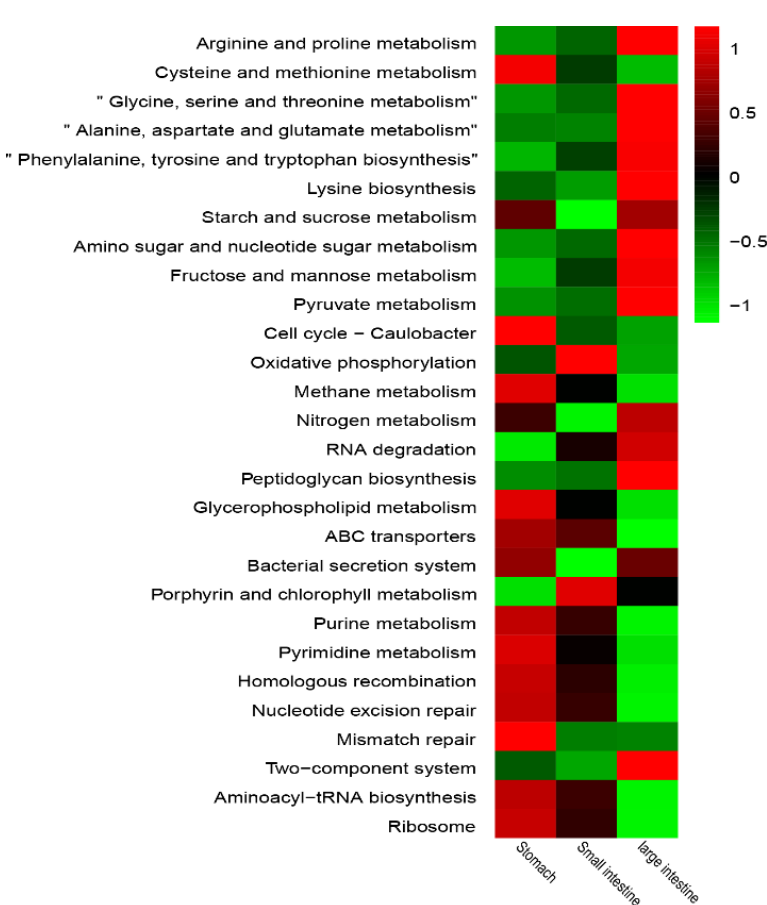
Figure 4. Heatmap shows enrichment of the predicted function genes (relative abundance > 1%) at level-3 between three regions (stomach, small intestine and large intestine) in the GIT of yaks. The relative abundance of each gene is shown in the heatmap and normalized by row. The total links and density (D) of the large intestine were greater than those of the small intestine, while the stomach had the smallest amount. The centralization of betweenness (CB) of the small intestine was the greatest, while the large intestine had the smallest (Figure 5a). The putative keystone genera were calculated based on the number of network degrees; the furcosa_ group was the keystone genus in the stomach and large intestine, and its relative abundance peaked to 0.11% in the large intestine and dropped to 0.06% and 0.05% in the stomach and small intestine, respectively. Rikenellaceae_RC9_ gut_group was the keystone genus in the small intestine, and its relative abundance was 12.23% in the stomach, which sharply fell to 3.17% and 4.72% in the small and large intestines, respectively (Figure 5b). The pH value added the biggest influence on the rumen bacterial composition, as shown by the 41.0% compositional variation (Figure 5c). The pH value negatively correlated with the fermentation parameters and positively correlated with the ratio of A:P. Additionally, the pH value significantly correlated with the relative abundance of the Akkermansia , Ruminococcaceae_UCG-010 , Rikenellaceae_RC9_ and Christensenellaceae_R- 7_ gut groups (Figure